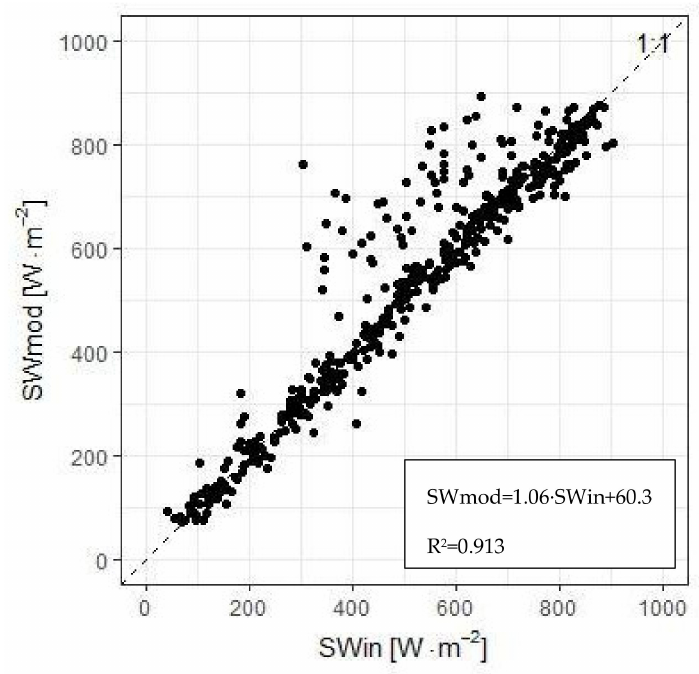
Figure 6. The half-hourly values of modeled (SWmod) vs. measured (SWin) solar irradiance.